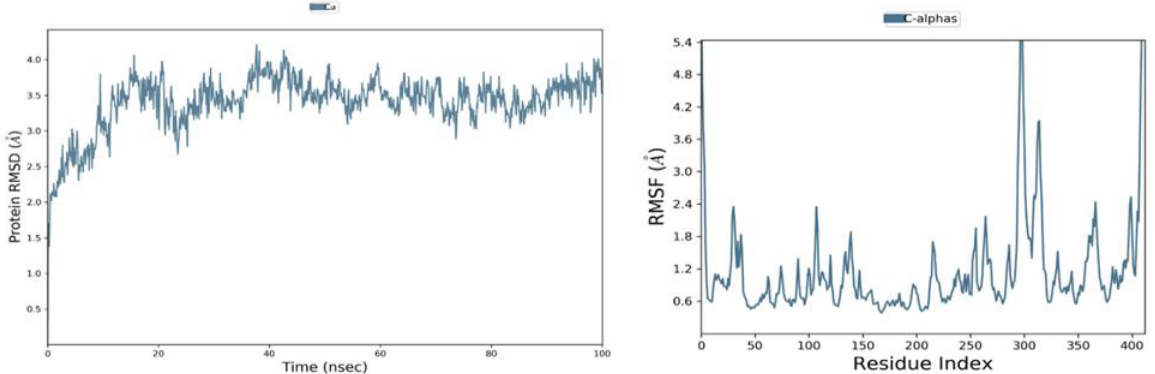
Figure 6. The C- α RMSD (Left hand side panel) and C- α RMSF (right hand side panel) of holo- enzyme.